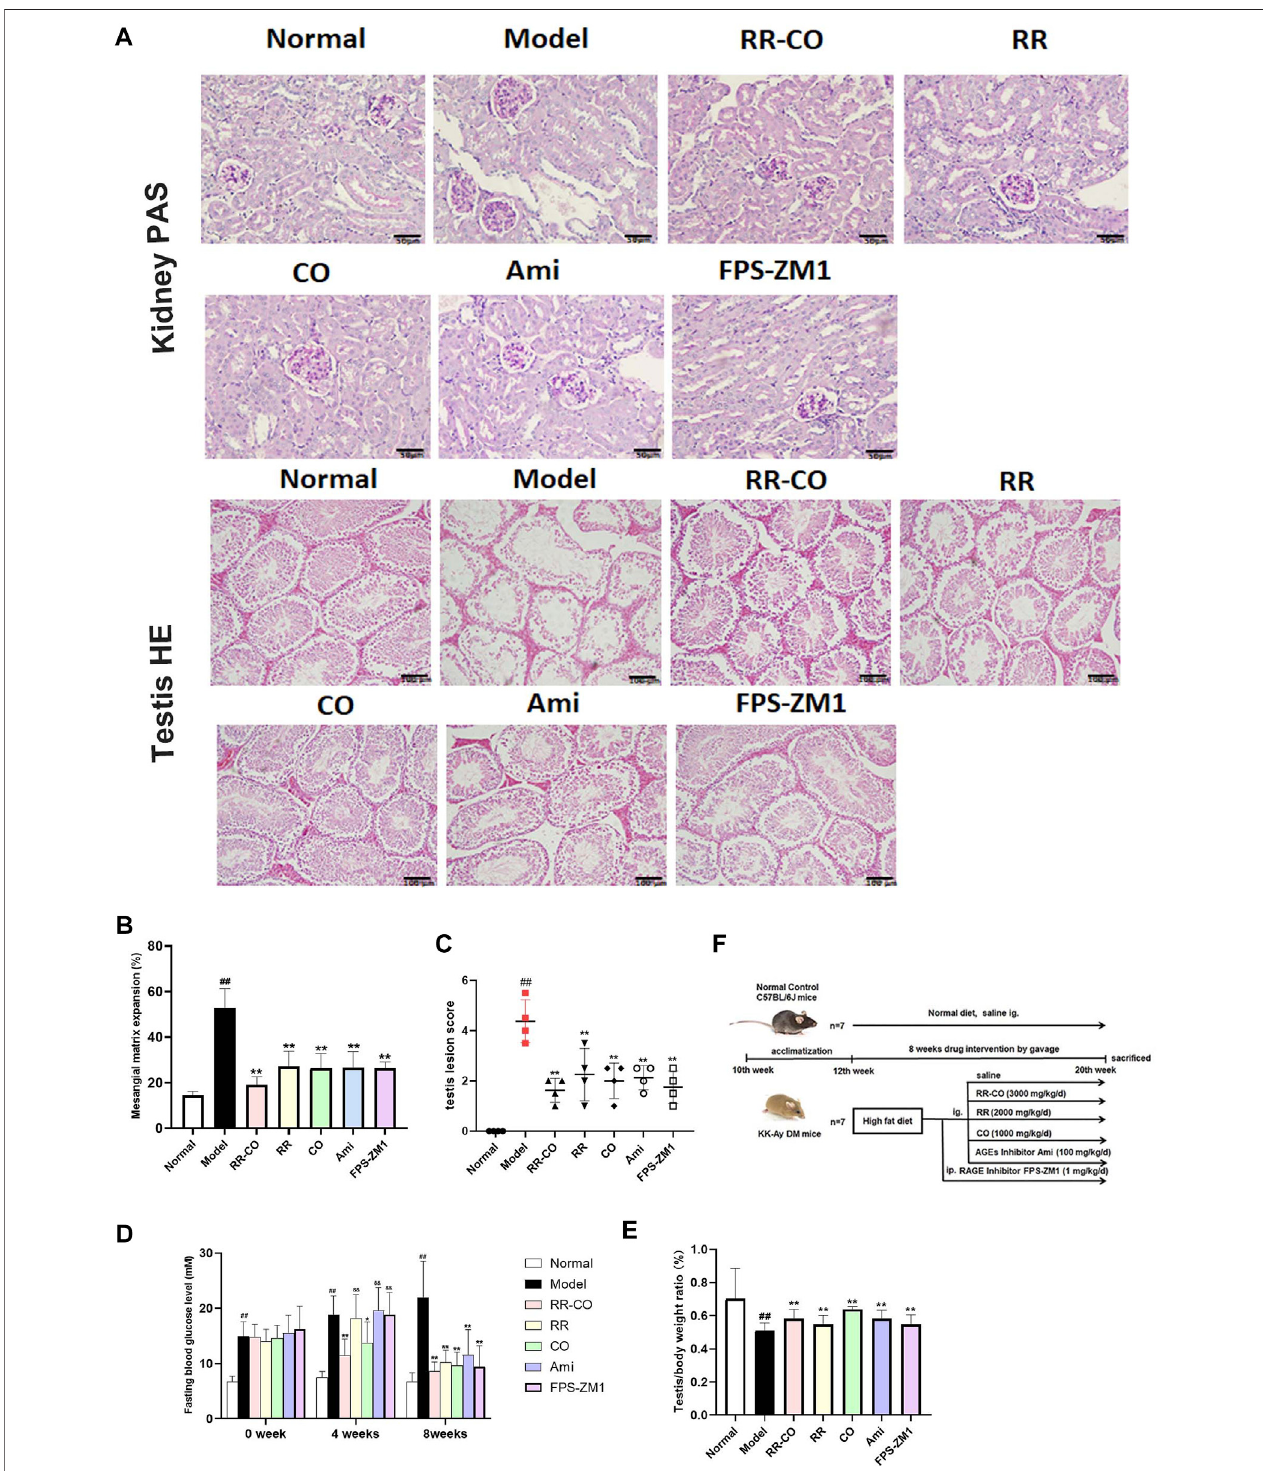
FIGURE 2 | RR-CO improved DM-induced renal and testicular morphology damages (A) PAS staining of kidney and HE staining of testis (200 × magni fi cation) (B) The glomerular mesangial matrix expansion was measured according to the PAS staining (C) Statistical chart of testicular lesion score (D) Fasting blood glucose levels (E) The testis/body weight ratio (F) Flowchart of the animal study. Signi fi cance: ## p < 0.01 vs. normal group; * p < 0.05, ** p < 0.01 vs. model group. && p < 0.01 vs. RR- CO group.